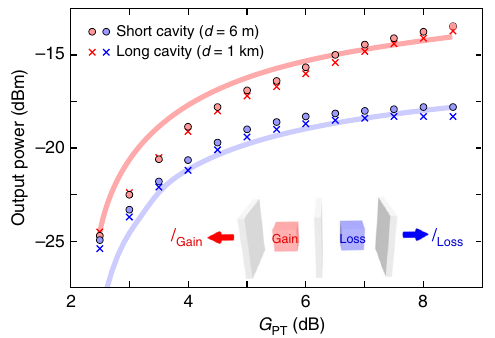
Fig. 4 Output power-scaling from a PT-symmetric laser with gain-loss contrast. Plot of the output power from the loss and gain laser cavity ports as the gain-loss contrast is increased while maintaining the PT-symmetric balance G L ¼ 1; inset shows the cavity con fi guration. Measured values are shown as circles and crosses for cavity con fi gurations of total lengths d = 6 m and 1 km, respectively. The solid blue and red curves are simulations of the output power from loss and gain ports, respectively, obtained from the nonlinear model of the coupled fi bre system in Eqs 2 – 3 after making use of measured values for the model parameters and fi tting the detuning Δ